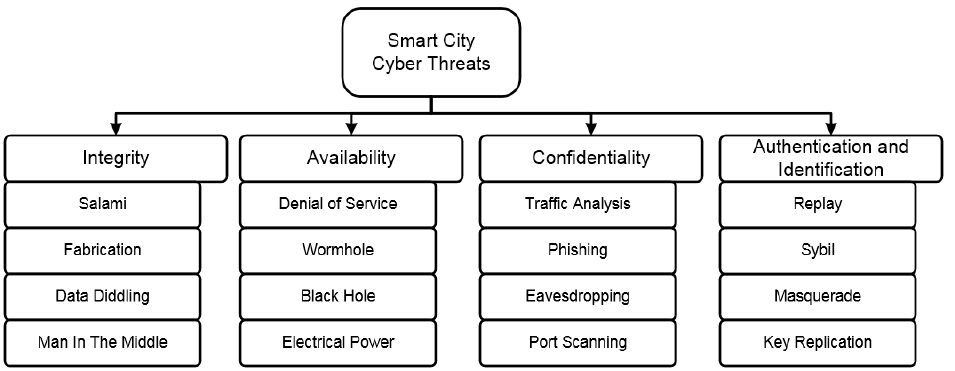
Figure 1. A common classification of the cyber threats at the smart city infrastructure.